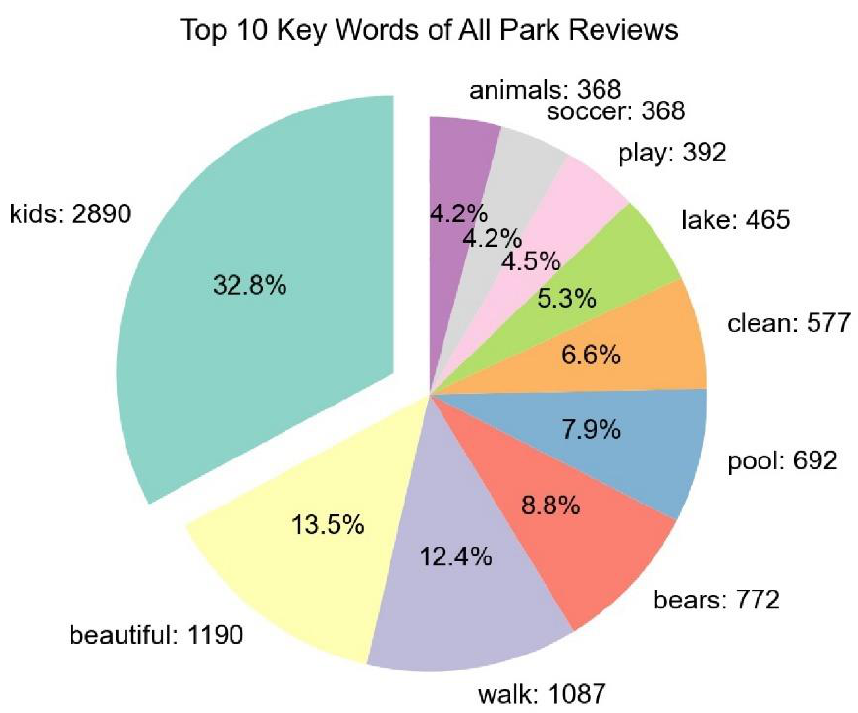
Figure 8. Pie chart of the top 10 park reviews: keywords frequency for all parks.